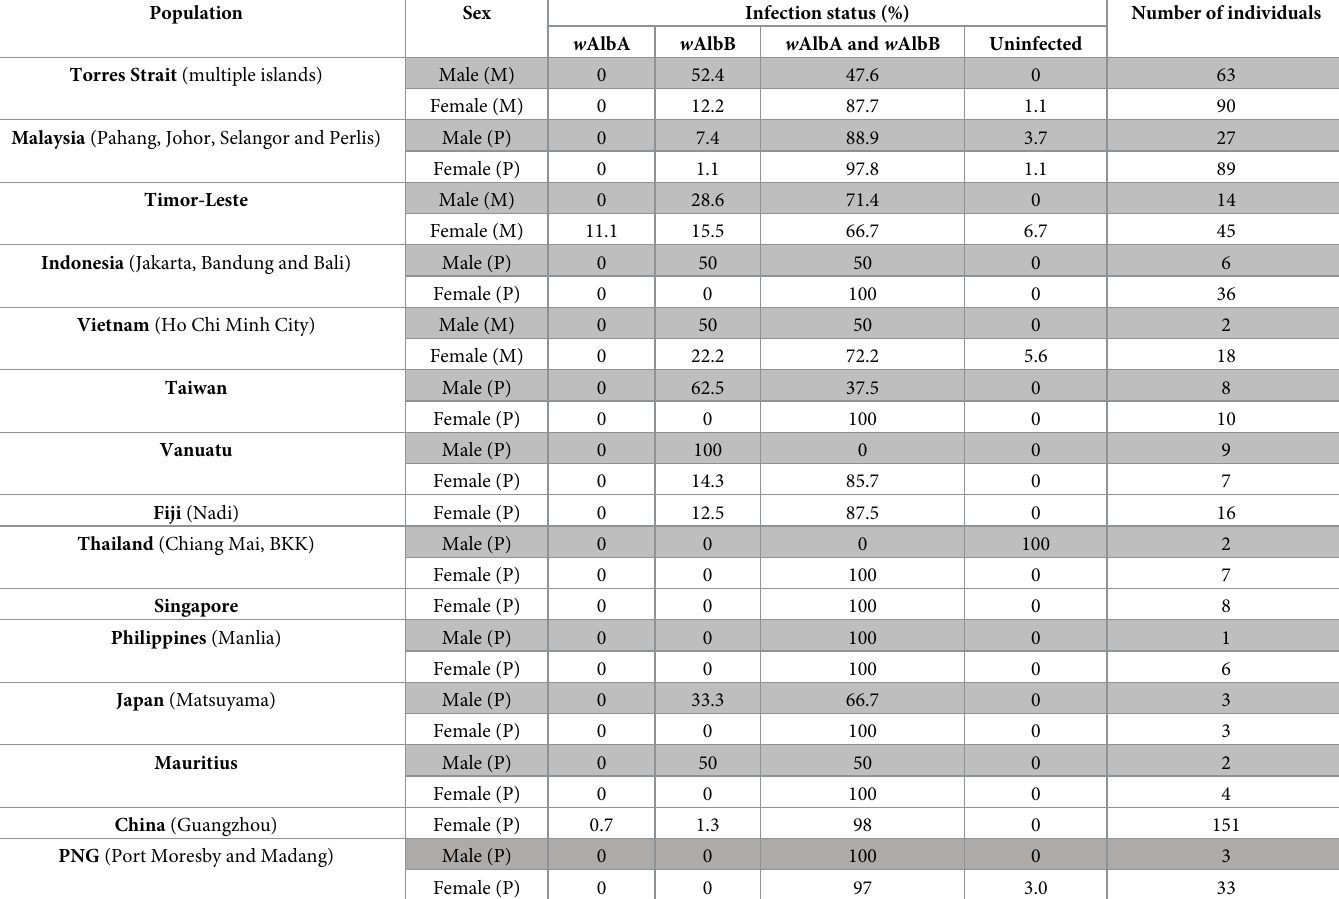
Table 3. Wolbachia infection status in Ae . albopictus females and males as assessed by qPCR screening. Sexes were identified morphologically or through the ML sequencing-based approach as indicated. Population Sex Infection status (%) Number of individuals